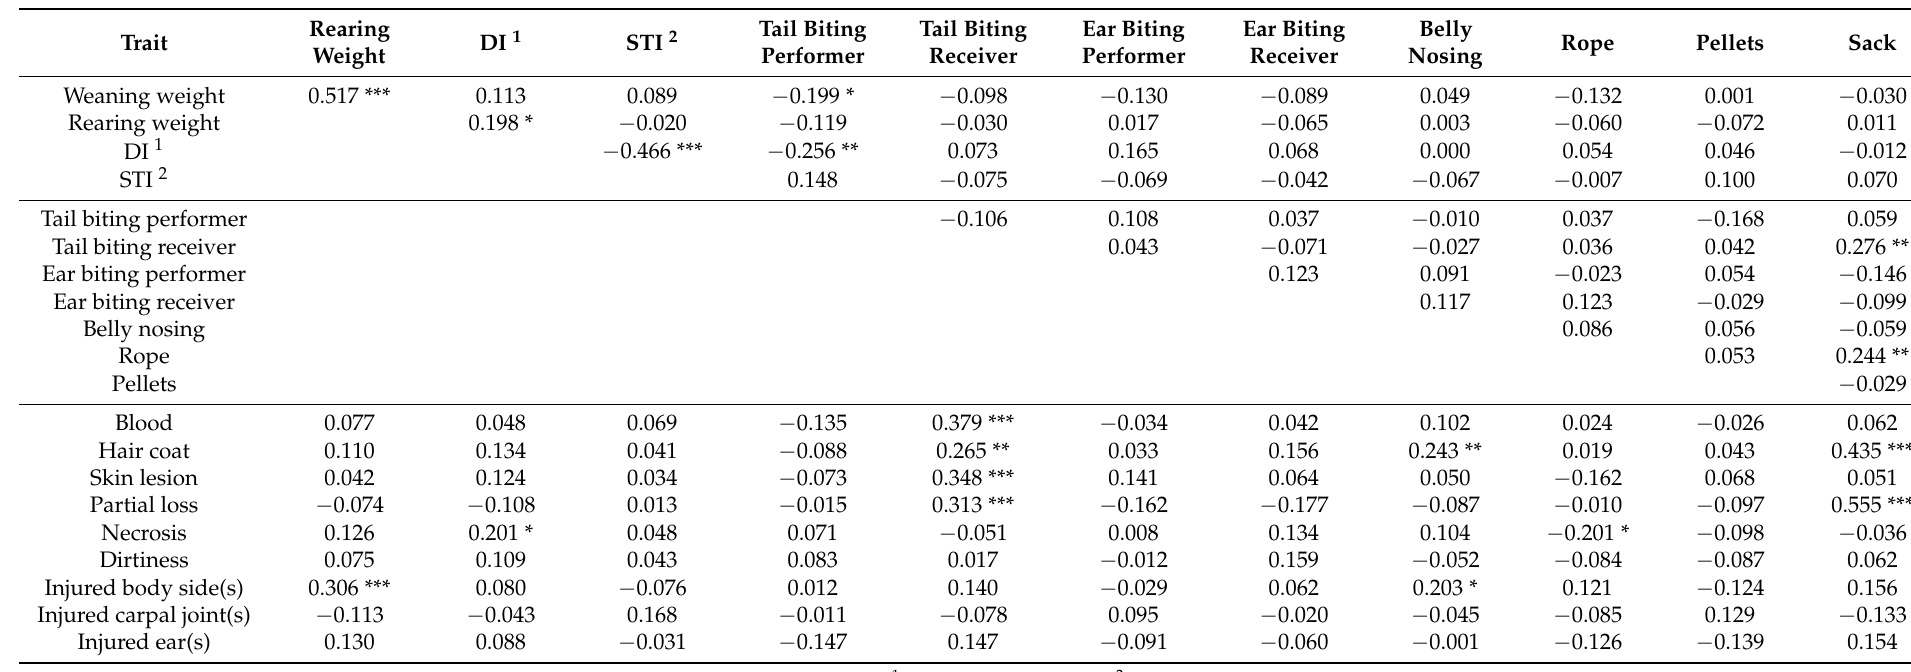
Table 8. Spearman’s rho (r s ) coefficients between Dominance Index and Social Tension Index during suckling, frequencies and percentages of manipulative behavioral traits during rearing and general health condition and tail lesions at the end of the rearing